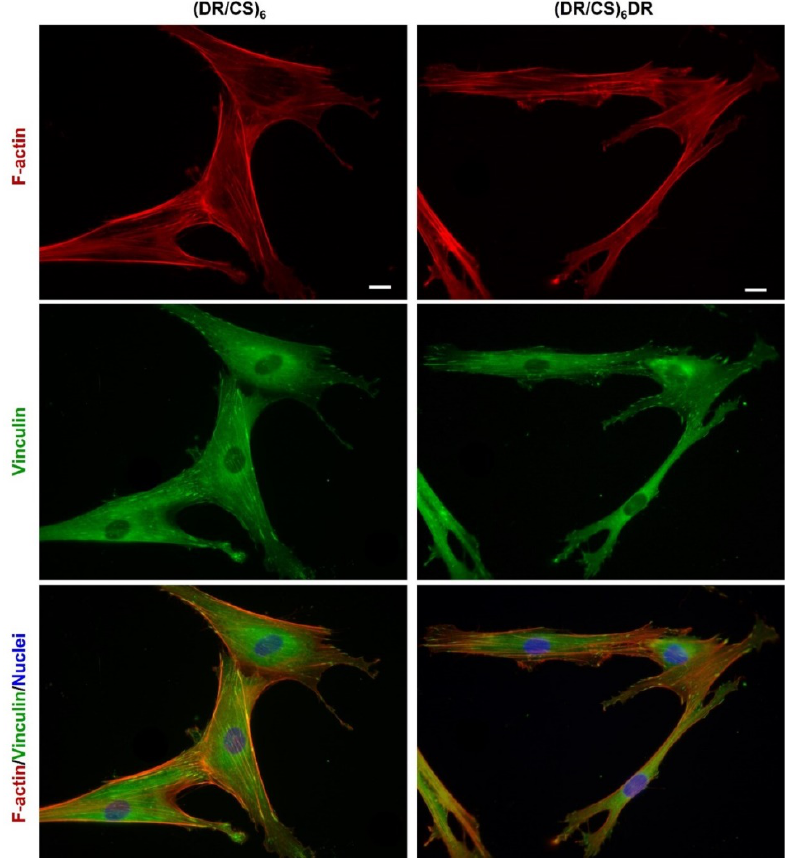
Figure 2. Changes in the actin cytoskeleton architecture in hUC-MSC grown on both types of DR/CS multilayer films. Cells were cultured in a medium supplemented with 2% FBS for 24 h and were then immunostained for vinculin and counterstained with TRITC-phalloidin (F-actin) and DAPI (nuclei). The scale bar represents 25 μm.